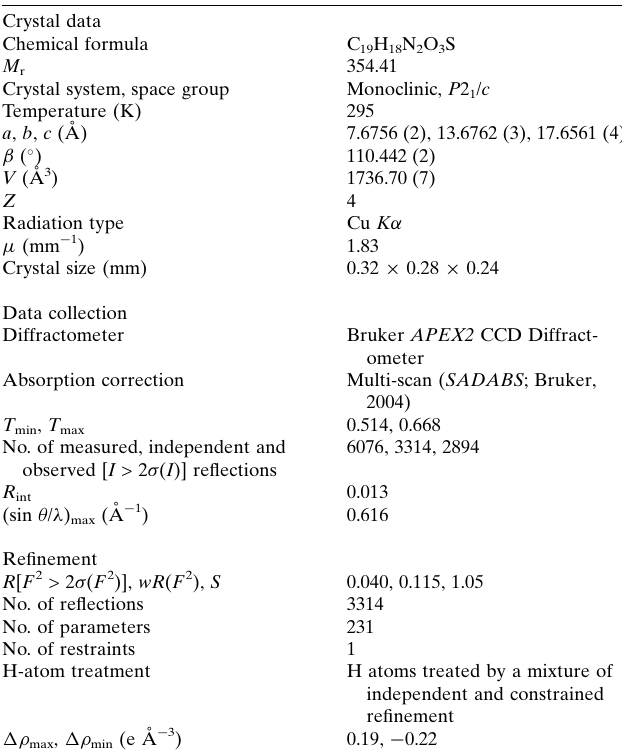
Table 2 Experimental details.